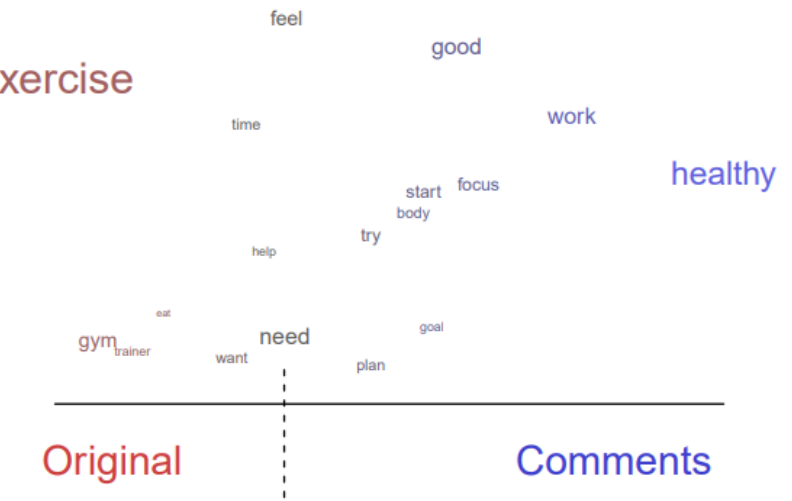
Figure 4. Difference in topic content between original threads and comments (exercise routine: Topic 14).